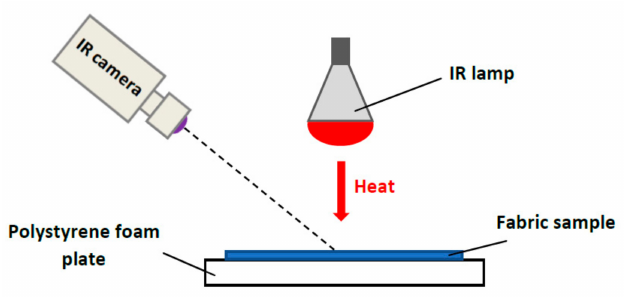
Figure 2. Measurement set-up for evaluation of heat-retaining properties of the